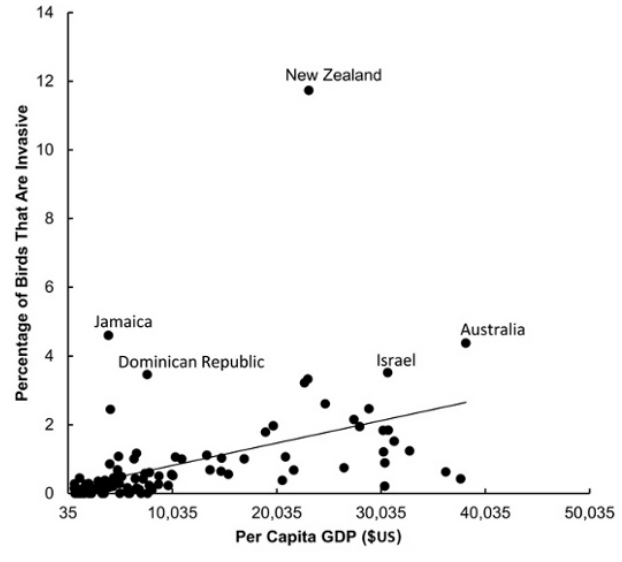
Fig. 2 . One of the two models best explaining the proportion of endangered birds was the total land area in a country. The proportion of endangered birds ranged from 0.21% to 24.05%, and total land area ranged from 5202 km² to 9,458,906 km². New Zealand is an extreme outlier.